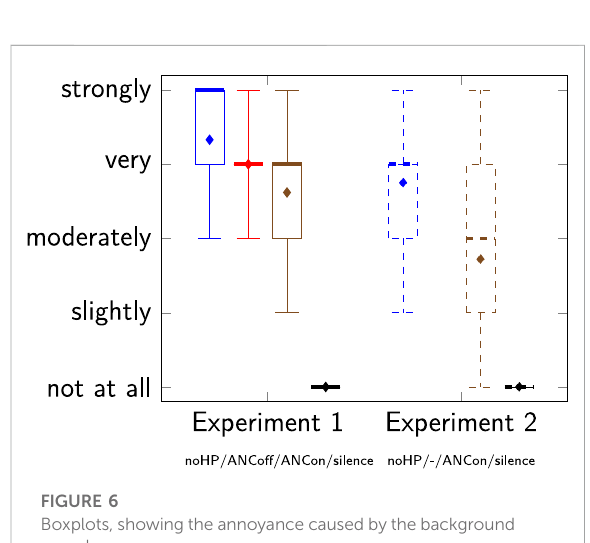
FIGURE 6 Boxplots, showing the annoyance caused by the background